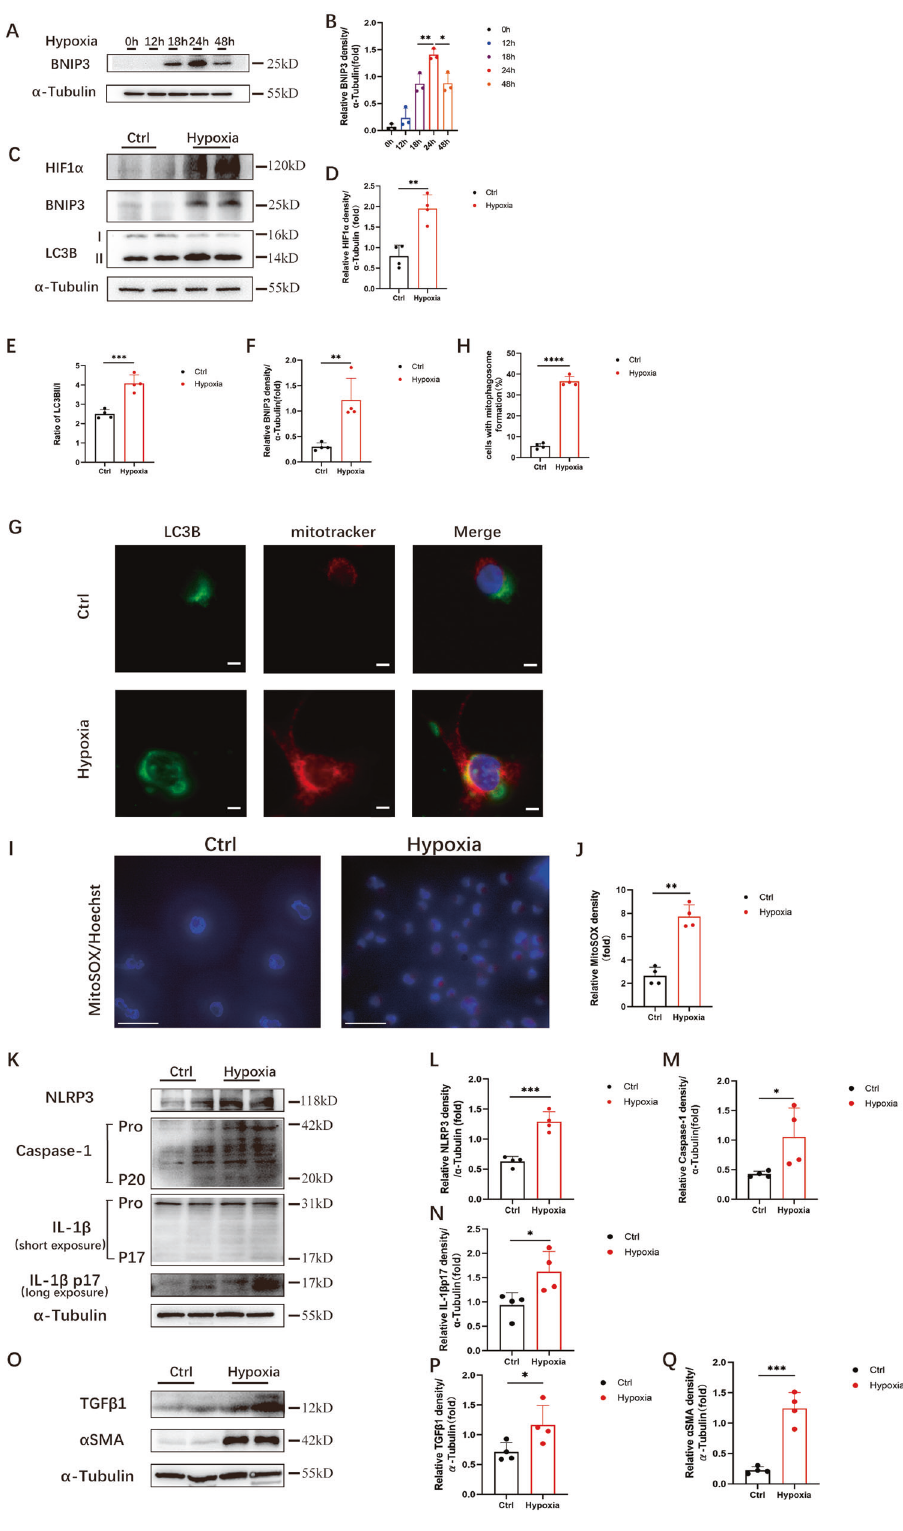
NLRP3 in fl ammasome activation and fi brosis were